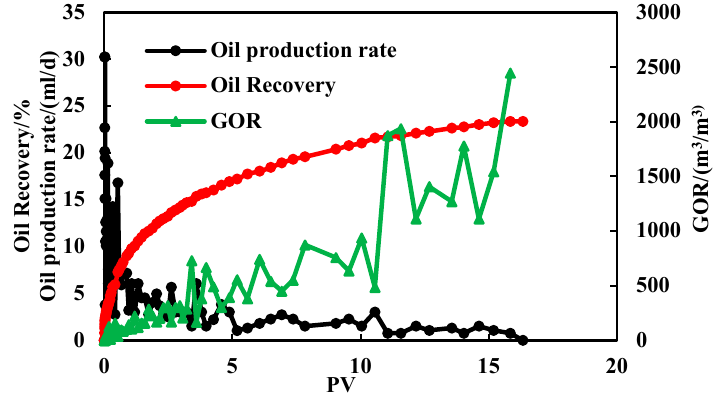
Figure 5. Production parameters of air flooding at different PV numbers. Figure 6 shows the production curve of air HnP in the full-diameter core at different times. Different from air flooding, there is a gas backflow stage in the early period of the puff period. At this time, only gas is discharged and basically no oil is produced, although the formation energy is sufficient and rapidly decreasing. As the subsequent proximal gas is continuously expelled, the oil phase gradually recovers at a relatively low GOR (50–660 m 3 /m 3 ). Therefore, air HnP development presents the characteristics of first producing gas and then producing oil. As a result, the GOR is high first and then low, and the oil production rate is first low and then high. Compared with air flooding, the air volume required for air HnP is also smaller, and the development time is significantly shorter (8660–270 min). Obviously, it takes more time (about 1500 min) for air flooding to achieve the same recovery factor (10.28%) of the first round of HnP. Therefore, it can be concluded that, in shale oil development, HnP development is conducive to more rapid oil